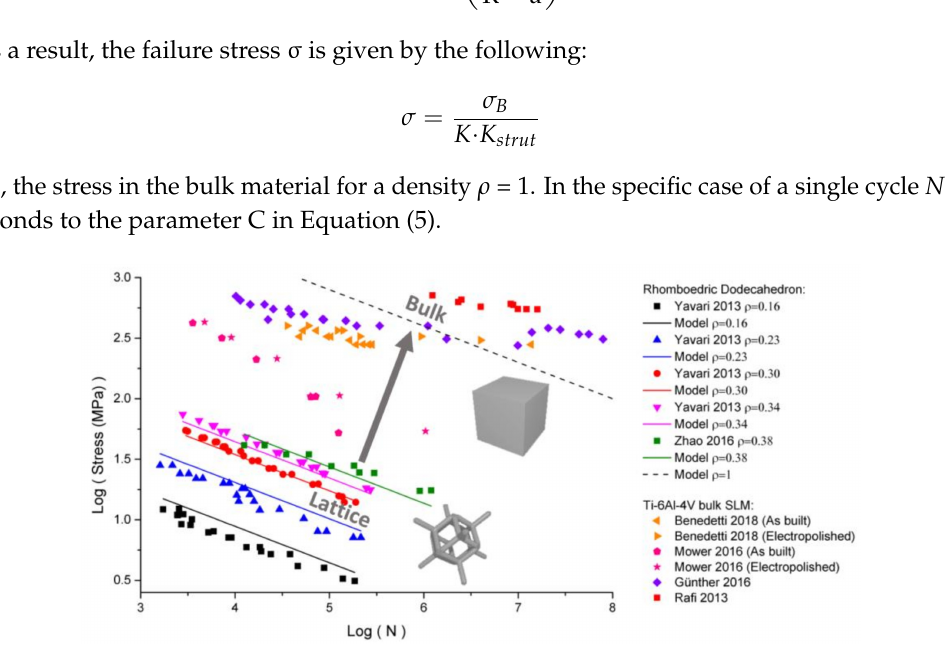
Figure 8. S–N curve of bulk and lattice materials (scatter plot), and the estimated values from the calculation of the stress concentration (solid